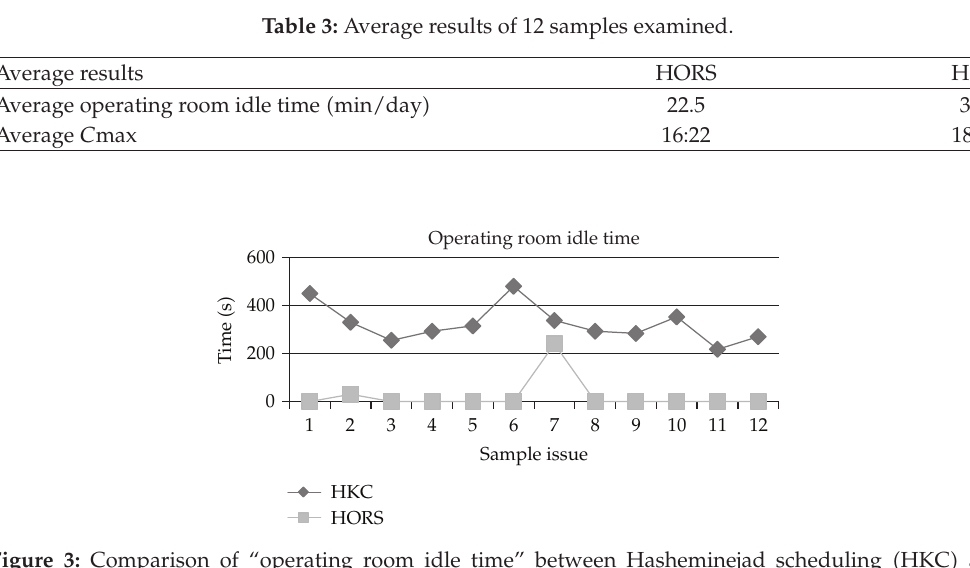
Figure 3: Comparison of “operating room idle time” between Hasheminejad scheduling (cid:2) HKC (cid:3) and proposed scheduling (cid:2) HORS (cid:3) .